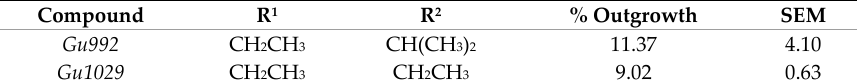
Figure 1. Structures of thalidomide analogs tested and docked. Scheme 1: structures of thalidomide, lenalidomide, and pomalidomide. Scheme 2 comprises compounds where R 1 is H, NO 2 , NH 2 , or OH; and R 2 is H, NH 2 , OH, OAc, or NHCH(CH 3 ) 2 ; Z 1 is O or CZ 1 is CH 2 . Z 3 is O or S; Z 4 is O or S, or C-CZ 4 is CH=CH. Scheme 3 comprises compounds where R 1 is H or NH 2 ; Z 1 is O or CZ 1 is CH 2 , or Z 2 is iminoglutarimide; ring B is substituted glutarimide or a heterocyclic or polycarbocyclic moiety. Schemes 4 and 5 comprise compounds where R 1 and R 2 are alkyl groups. Compounds have been previously described: Scheme 2 [18], Scheme 3 [18,19], and Schemes 4 and 5 [20]. Outgrowth from rat aortic rings after a 5-day incubation is given as a percentage of control outgrowth. SEM is the standard error of the mean. A minimum of three rings was used per compound. Asterisk (*) denotes chiral